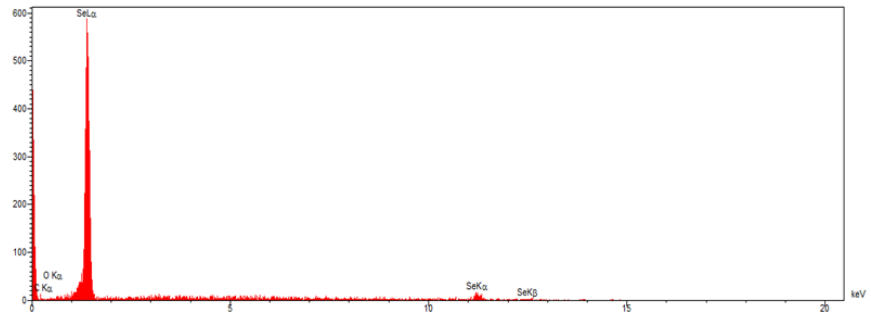
Figure 4. EDS Analysis of Se NPs.